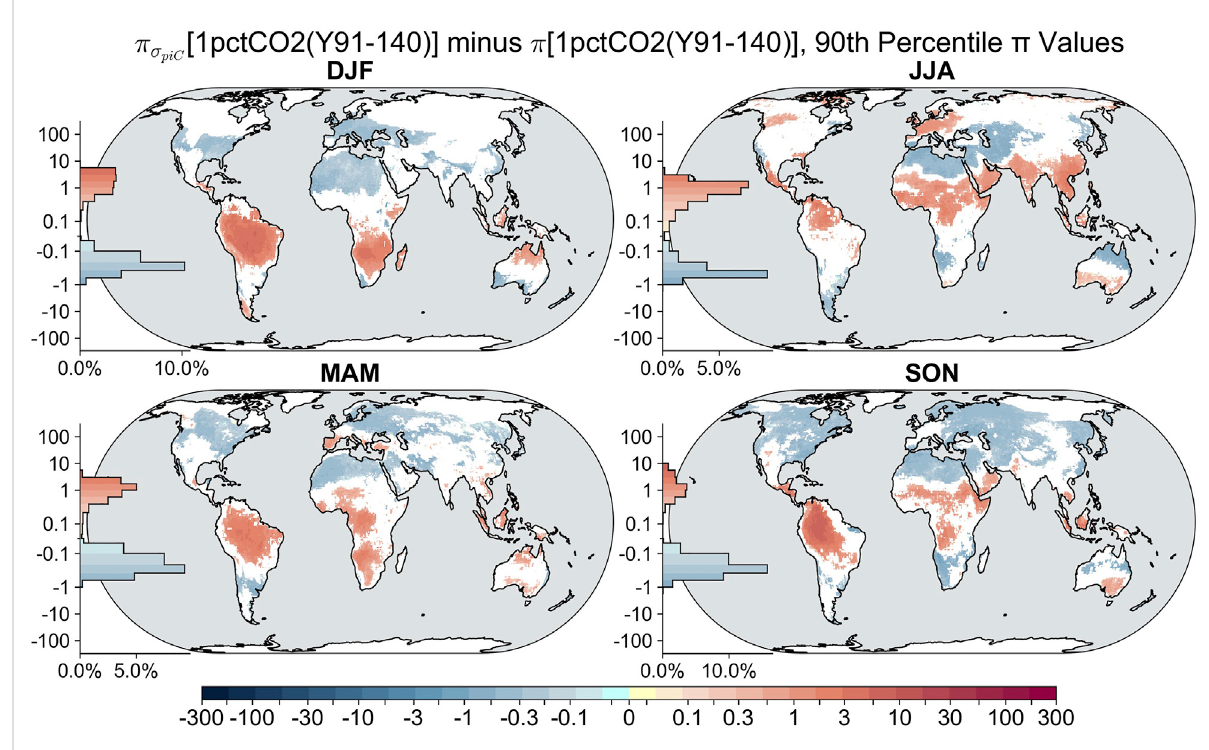
FIGURE 8 As in Figure 7 but with future values of π (dimensionless) based on means and standard deviations from the piControl